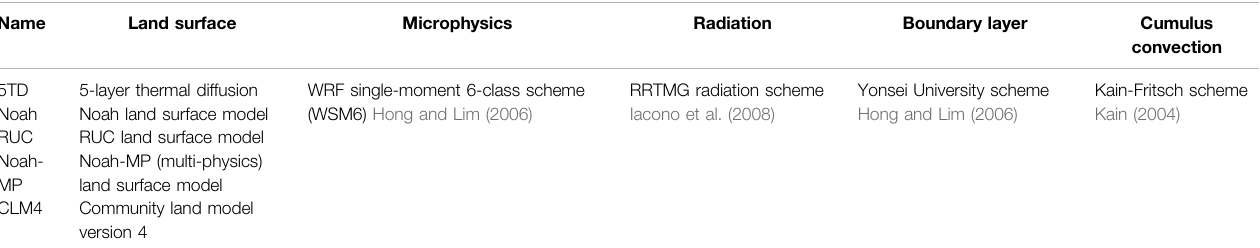
TABLE 1 | Overview of the physical parameterizations used in this study. The microphysics, radiation, boundary layer and cumulus convection schemes were the same for different